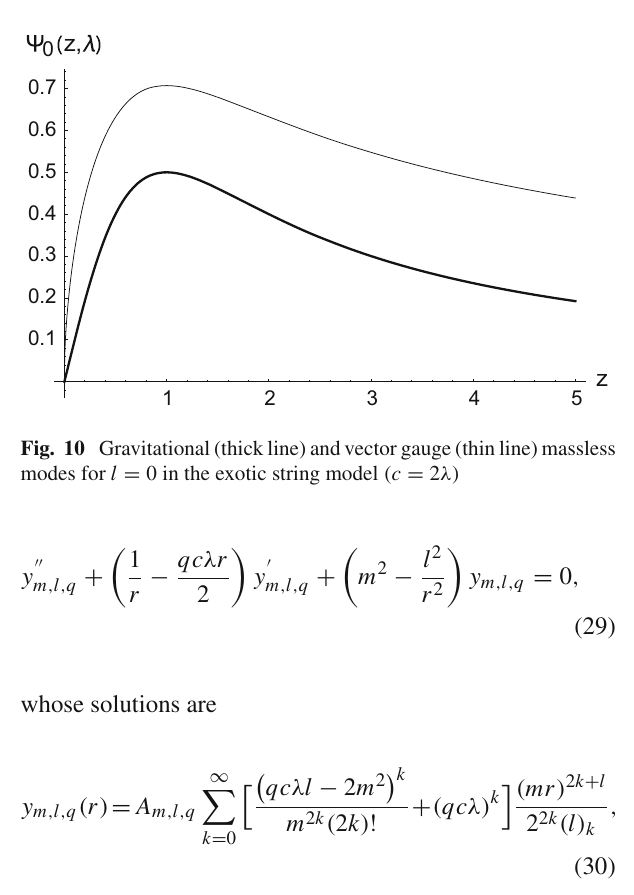
Fig. 9 Gravitational (thick line) and vector gauge (thin line) massless modes for l = 0 in the warped disk model ( c = 2 λ)